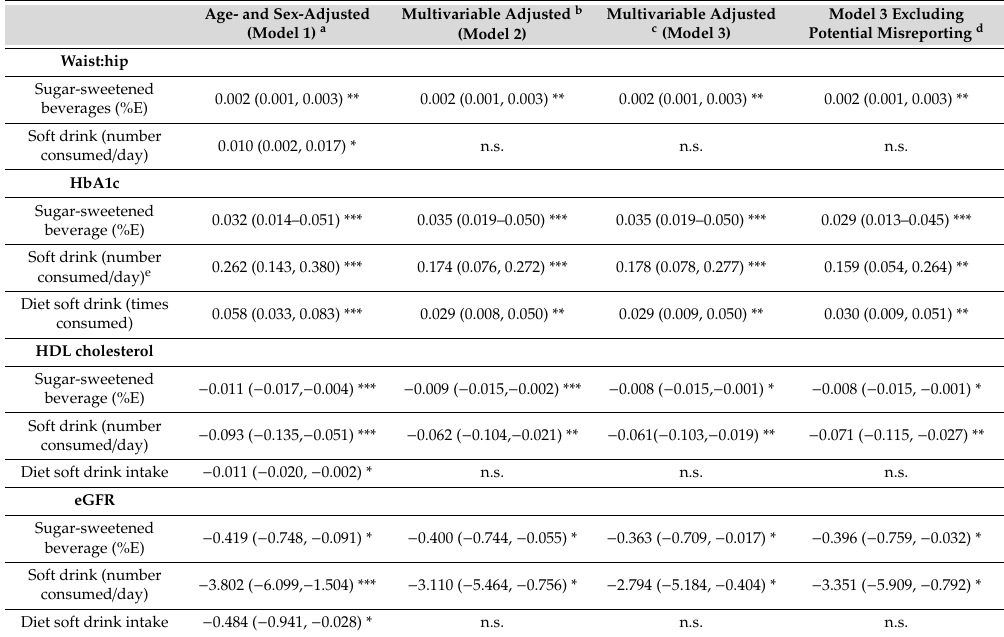
Table 6. Beverage intakes and modifiable cardiometabolic risk